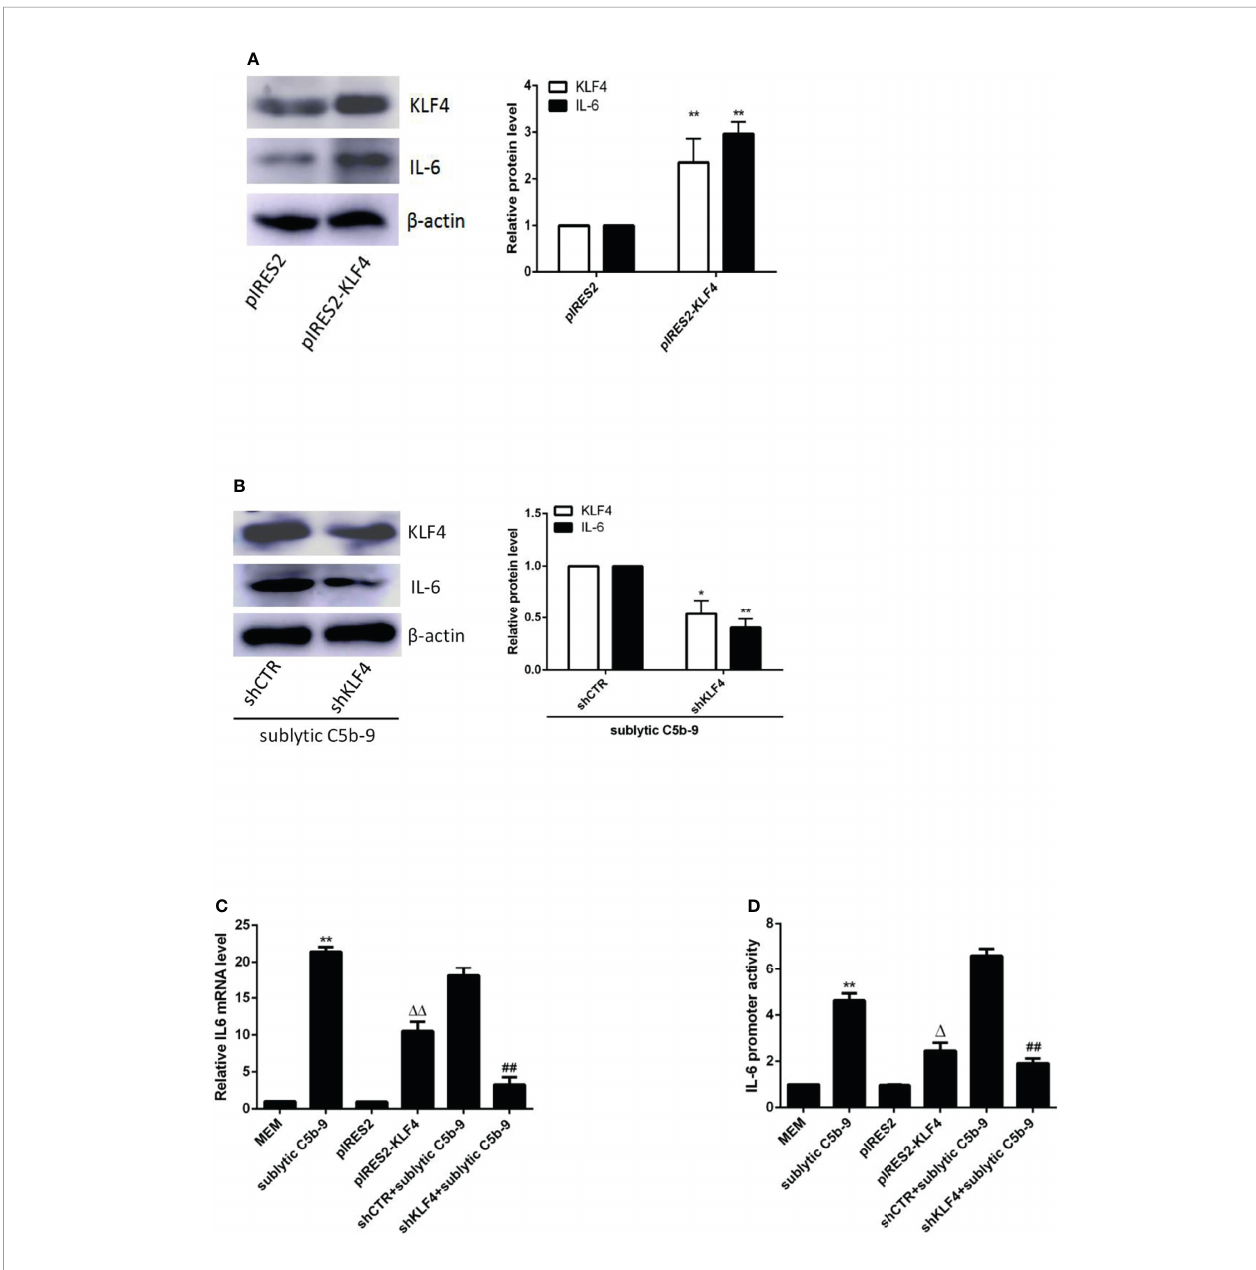
FIGURE 2 | Effect of KLF4 on IL-6 expression in sublytic C5b-9-stimulated GMCs. (A – C) GMCs were transfected with pIRES2, pIRES2-KLF4, shCTR, or shKLF4 vector for 48 h and then incubated with or without sublytic C5b-9 for 3 h. (A, B) IB analysis of KLF4 and IL-6 (*p < 0.05, **p < 0.01 vs. pIRES2 or shCTR + sublytic C5b-9). (C) qPCR analysis of IL-6 (**p < 0.01 vs. sublytic C5b-9; DD p < 0.01 vs. pIRES2; ## p < 0.01 vs. shCTR + sublytic C5b-9). (D) Luciferase activity assay of IL-6 reporter ( − 1,791 to +30 nt) (i.e., full-length construct) in GMCs transfected with pIRES2, pIRES2-KLF4, shCTR, or shKLF4 for 48 h and then stimulated with or without sublytic C5b-9 for 3 h (**p < 0.01 vs. sublytic C5b-9; D p < 0.01 vs. pIRES2; ## p < 0.01 vs. shCTR + sublytic C5b-9). Data are representative of three independent experiments with similar results or are shown as mean ± SD from three independent experiments. GMCs, glomerular mesangial cells; IB,